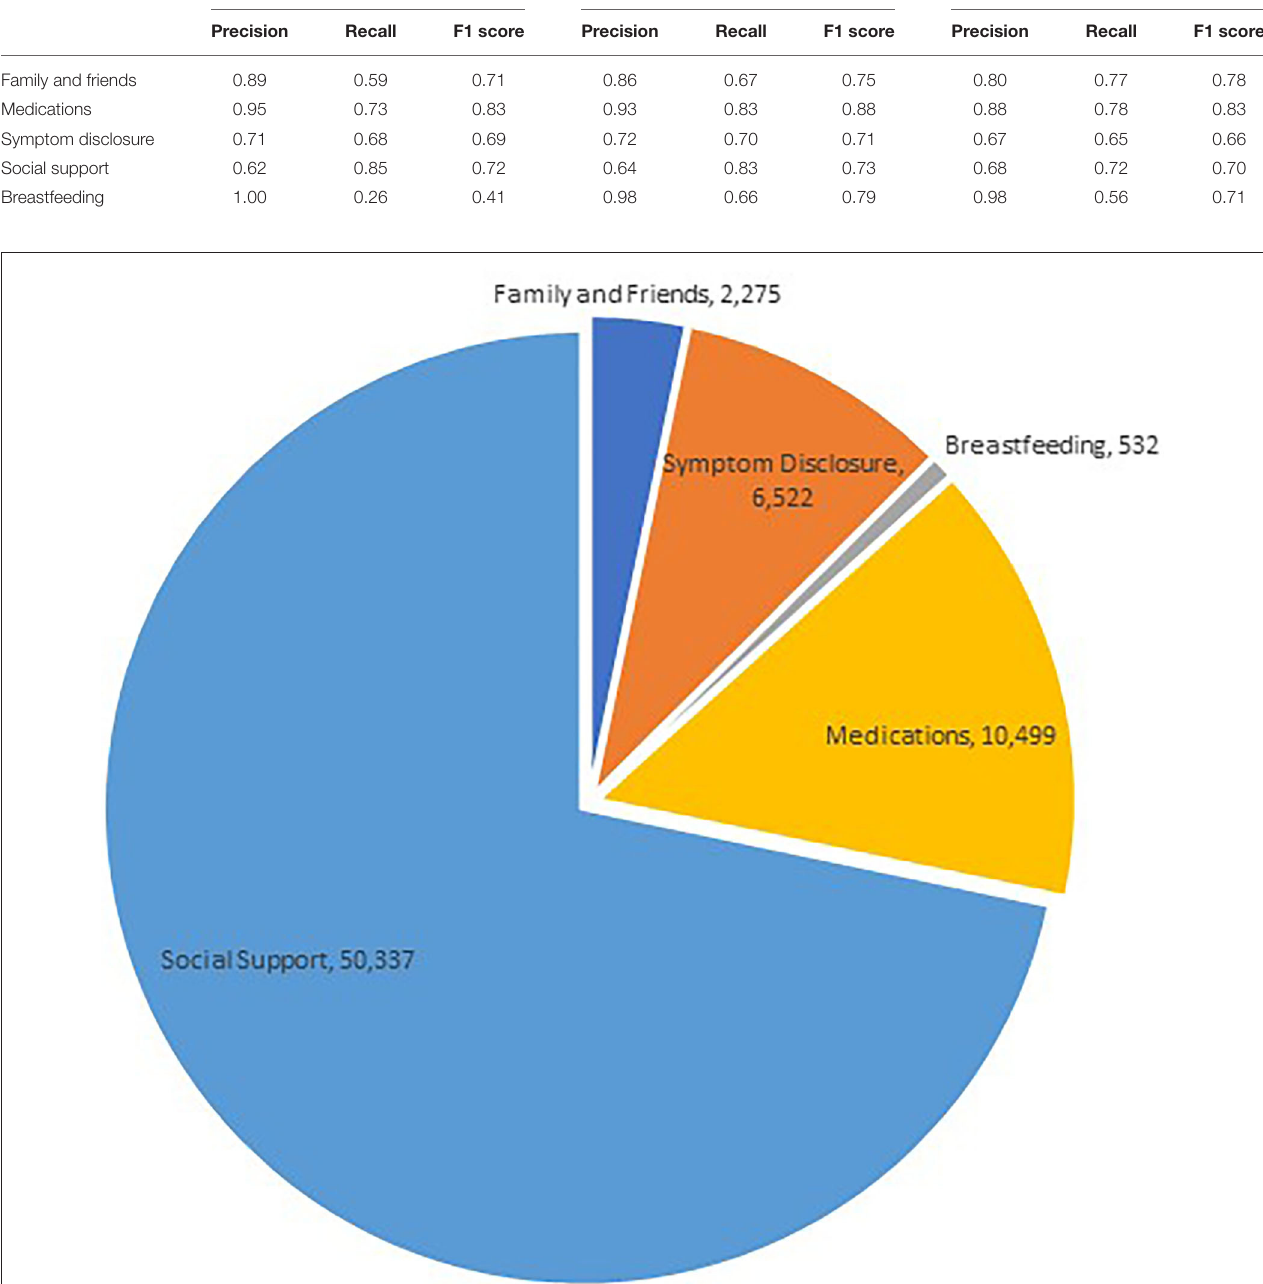
FIGURE 3 | Thematic distributions of PPD-related online social interactions using automated classification. for reassurance or further information on a topic. User posts had an average authenticity score of 65.71. Finally, the average tone score of 39.52 indicates that while many of the posts do consist of emotional content, most of them also show objective content. In regards to the emotional characteristics of the dataset,